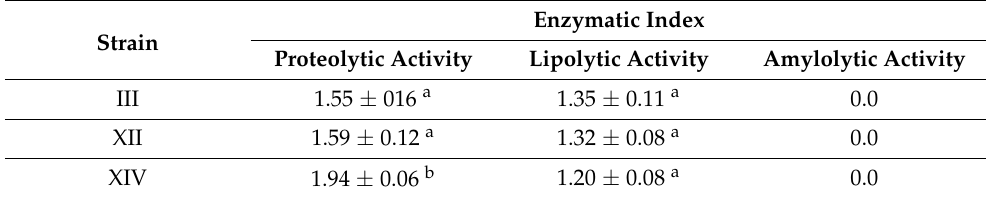
Table 2. Hydrolytic capacity of Trichophyton ajelloi